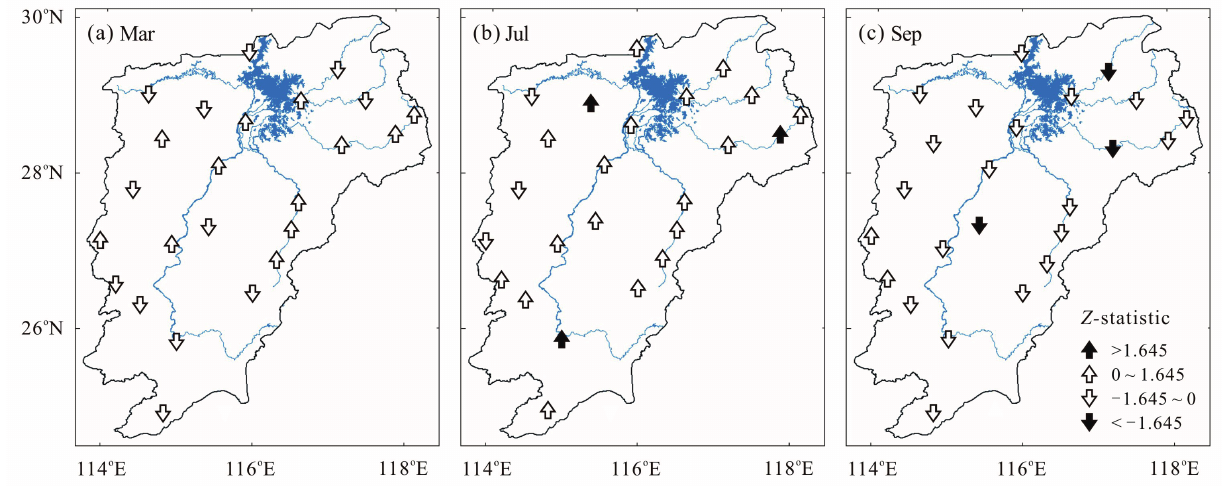
Figure 9. Spatial patterns of the long-term trends of DWATI in March ( a ); July ( b ) and September ( c